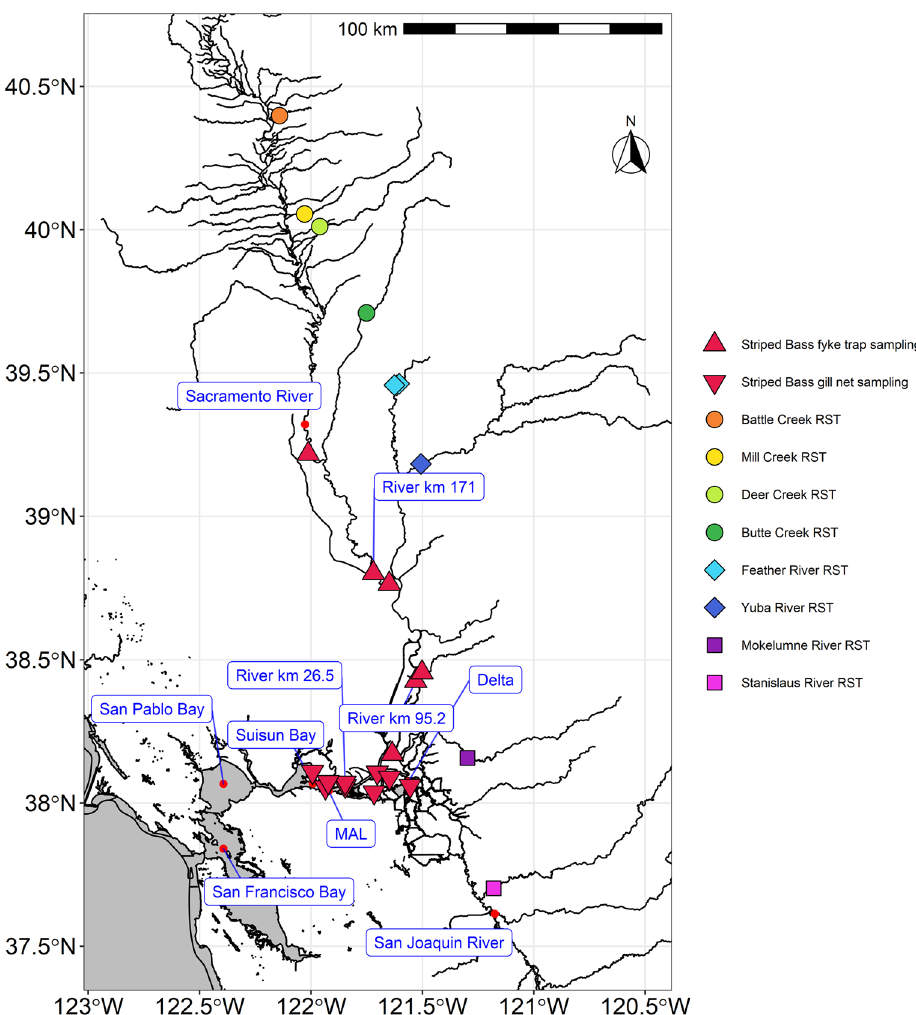
Figure 4. Sampling locations in this study are shown as symbols on the map of the San Francisco Bay-Delta and Central Valley, California. Each species and location sampled is denoted by color, with like areas grouped by symbol: triangles for Striped bass sampling and for the rotary screw trap (RST) sampling of juvenile Chinook salmon, circles denote the upper tributaries of the Sacramento River, diamonds for Feather River watershed, and squares represent the non-Sacramento River tributary watersheds. The map was made using program R version 3.6.3 49